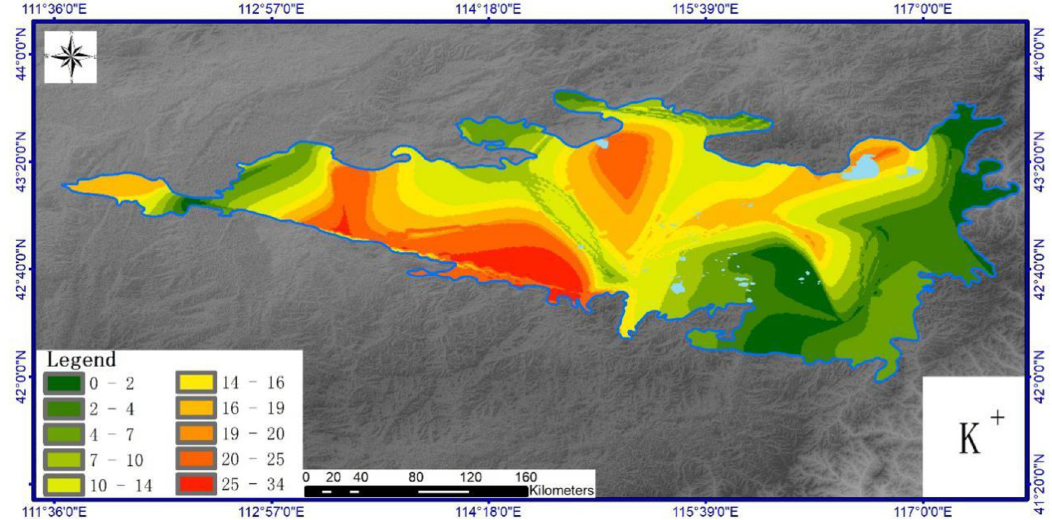
Fig 5. Spatial distribution of soil K + in Hunshandake sandy land (Cartographic software:Arcgis10.5).